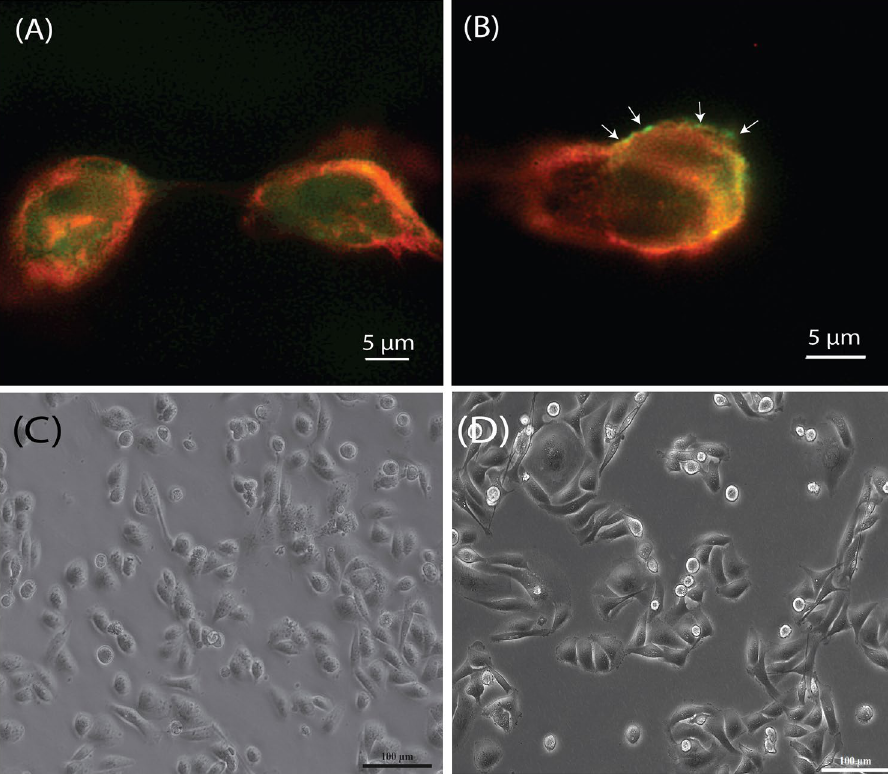
Figure 3. Stimulated emission depletion (STED) microscopy on MDA-MB 231 breast cancer cells incubated with FITC tagged nanoconstruct after 2 hours. ( A ) FITC tagged nanoconstruct with aptamer gaining entry into cells hence resulting in fluorescence within the cytoplasm while ( B ) FITC tagged nanoconstruct without the aptamer was unable to transfect the cells and fluorescence was found to be localized near the outer membrane. Light microscopy of the 231 cells at the 4-hour mark after transfection with ( C ) lipofectamine with the three single strands antisense RNA and ( D ) the nanoconstruct with AS1411 aptamer and three hybridized antisense RNA. Note the morphological disturbance induced by the presence of the lipofectamine where overall became stouter with lesser protrusions radiating